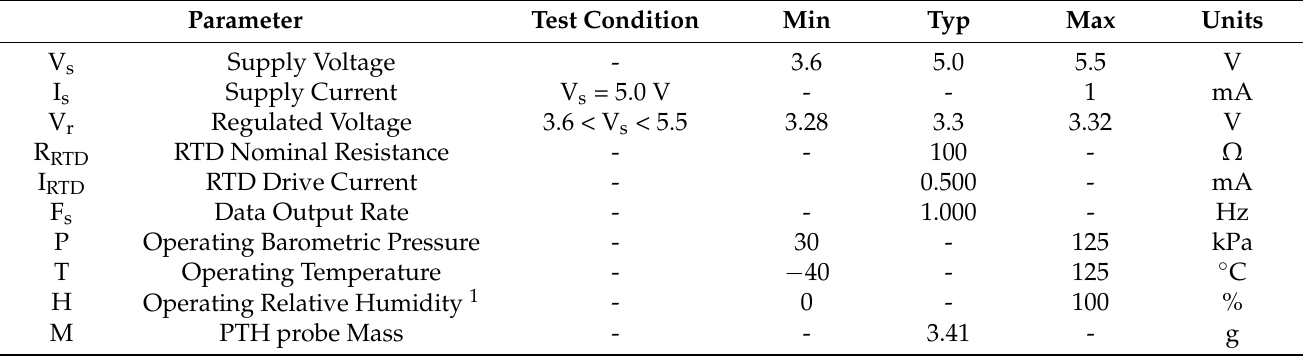
Figure 7. Dimensioned drawing of the PTH probe. Units are shown in [millimeters] and inches. Table 5 summarizes the PTH probe operating characteristics. While the PTH probe was designed to operate from a nominal 5 VDC source (V s ), the linear voltage regulator used to supply 3.3 VDC (V r ) to all downstream components allowed for a range of input voltages with negligible change in PTH probe performance. Table 5. PTH probe operating characteristics.